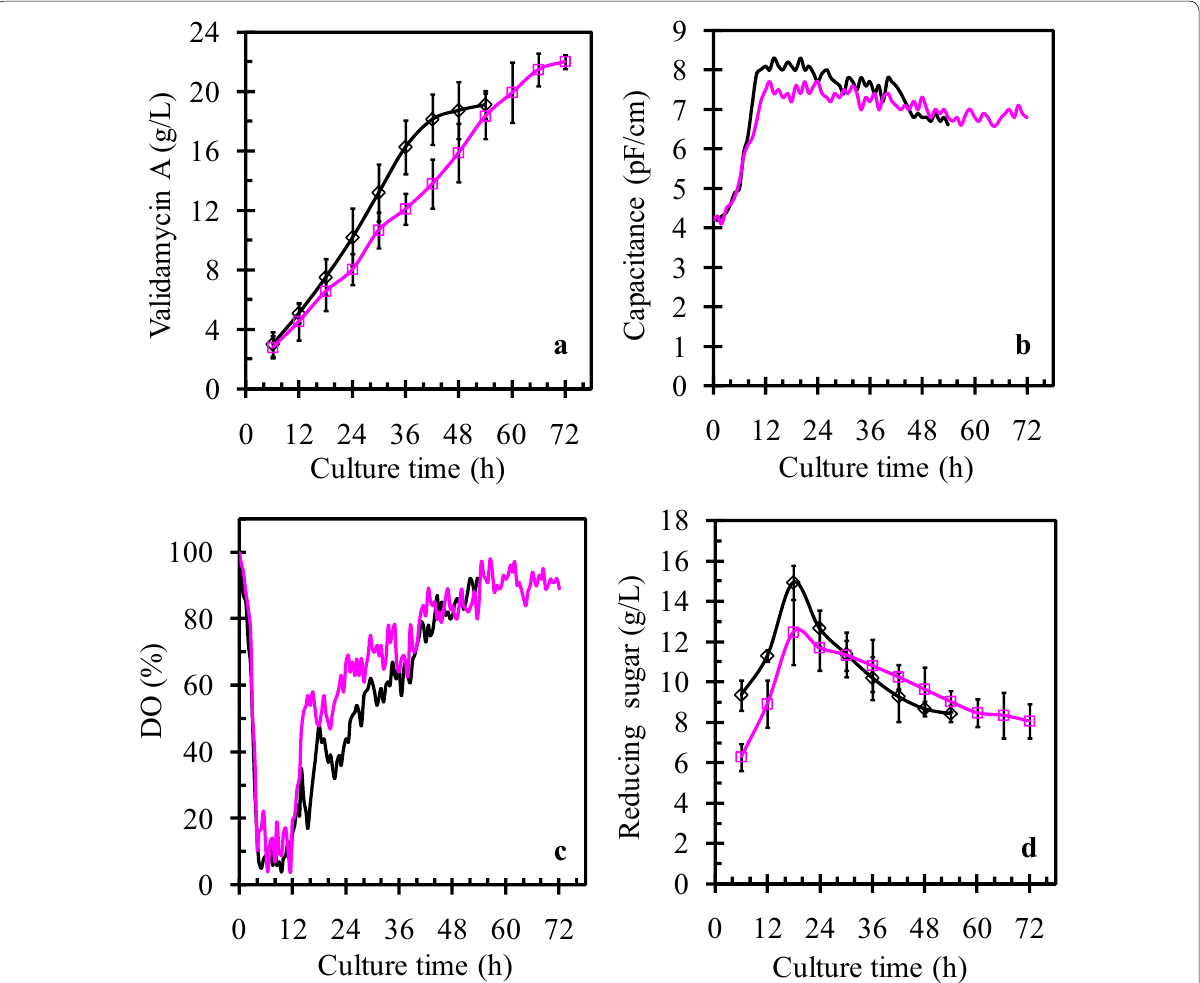
Fig. 1 Time courses of validamycin A batch fermentation with tap water in 50-L bioreactor by S. hygroscopicus K18 (black line) and K2509 (red line): a profiles of validamycin A, b profiles of capacitance measurement in broth, c profiles of reducing sugar concentration, and d profiles of DO